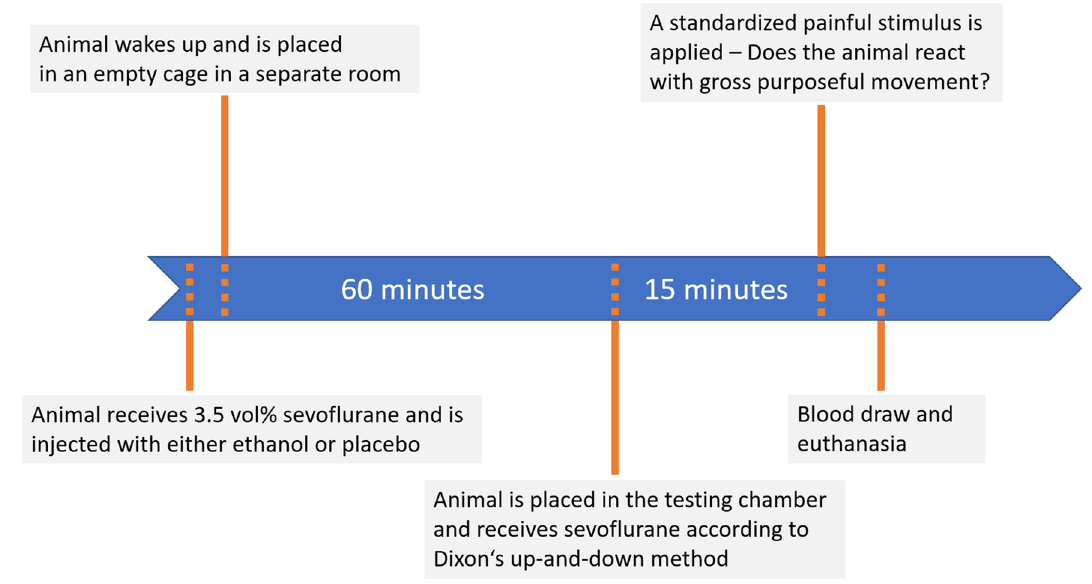
Figure 1. Timeline graphic showing the timing of major events such as intraperitoneal injection and determination of the response to the standardized